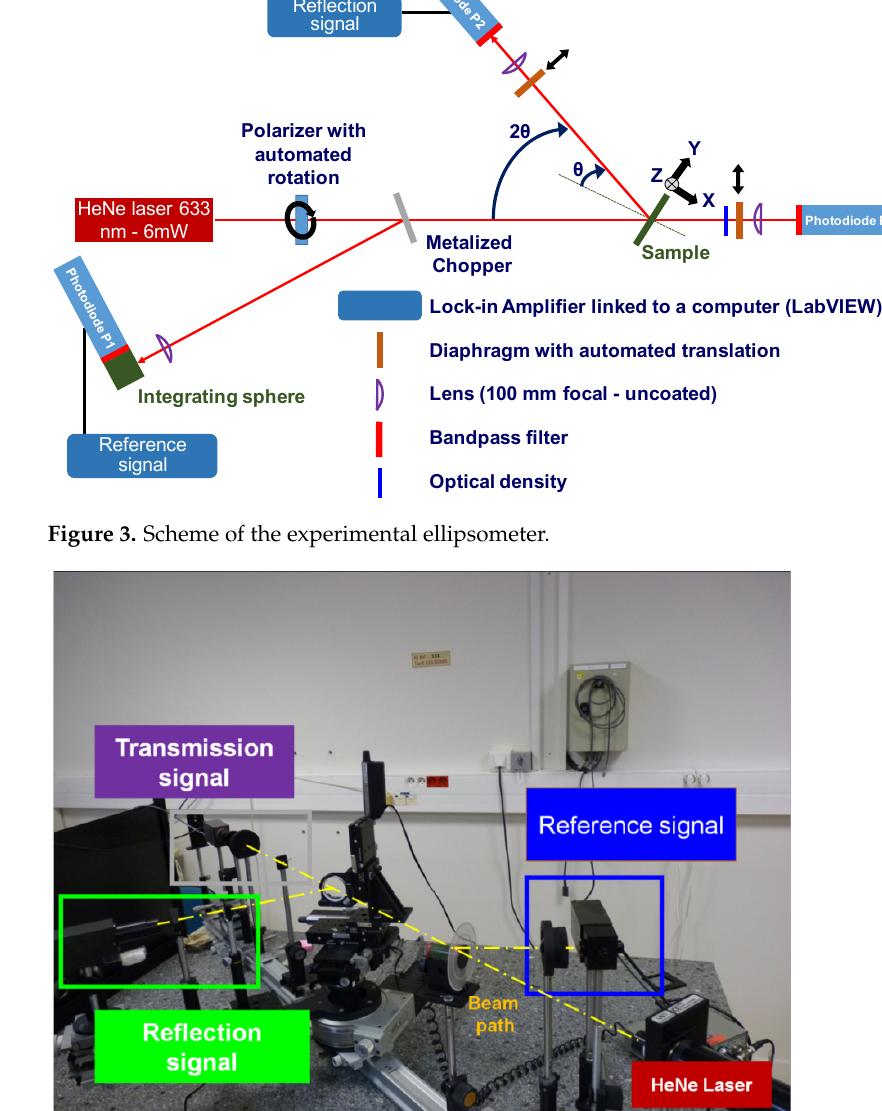
Figure 4. Picture of the experimental ellipsometer.